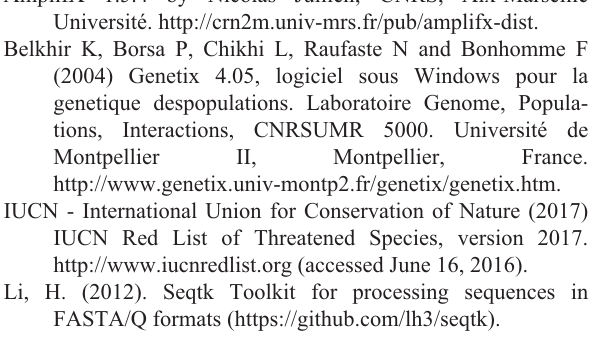
Figure S1 – Probability of identity (PI), and the PI between siblings (PI ) for the 15 microsatellite loci. sib Table S1 – All tetranucleotide loci for P. adeliae, P. papua P.